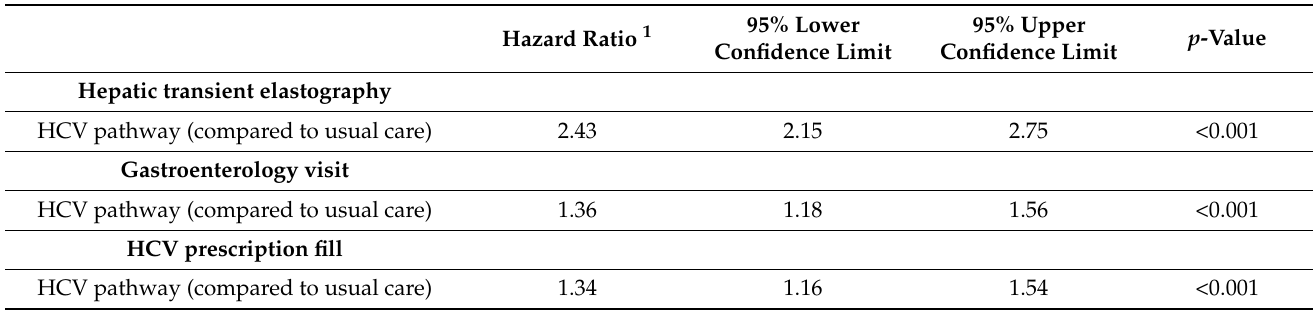
Table 4. Among chronic HCV monoinfected patients, Cox proportional hazards models comparing the instantaneous risk of completing steps along the HCV care cascade between patients in the HCV pathway and patients undergoing usual